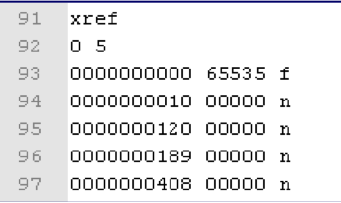
Figure 3. A snapshot of a cross-reference table.